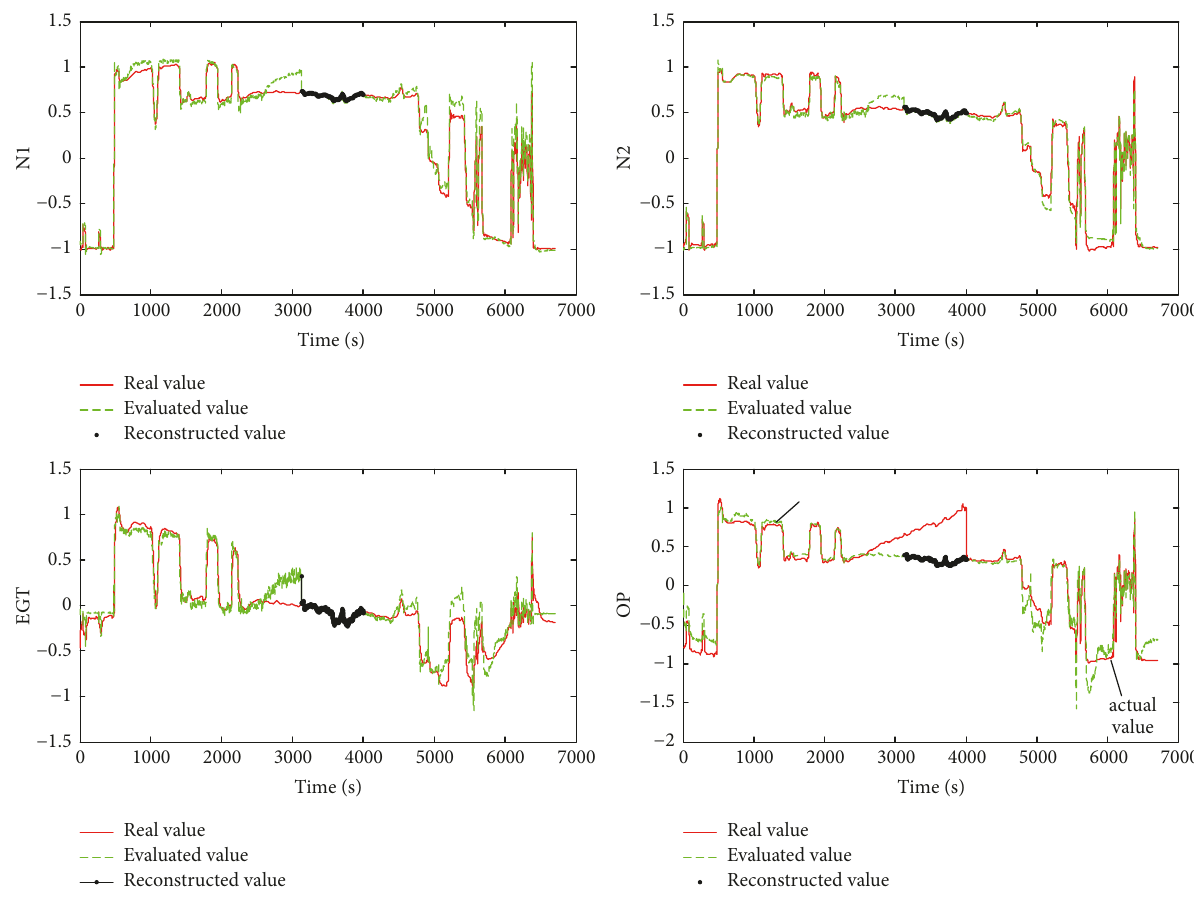
Figure 13: Reconstruction results.